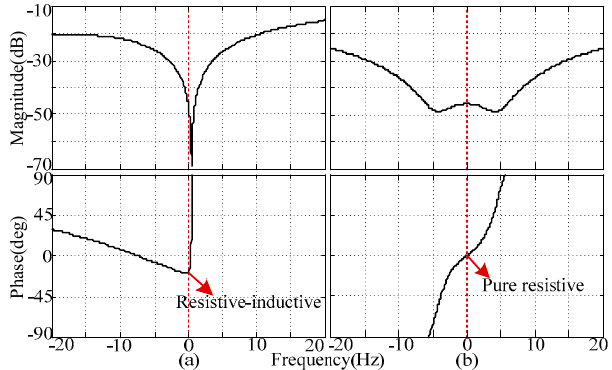
Figure 11. Bode diagram of Z(s). ( a ) Considering coupling; ( b ) Regardless of coupling.